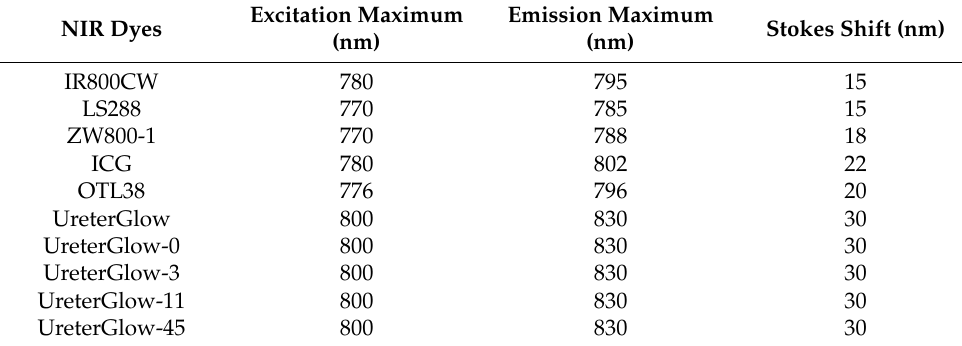
Table 1. Photo-physical properties of NIR dyes used for fluorescence-guided surgeries and new PEGylated probes. Excitation Maximum Emission NIR Dyes (nm)